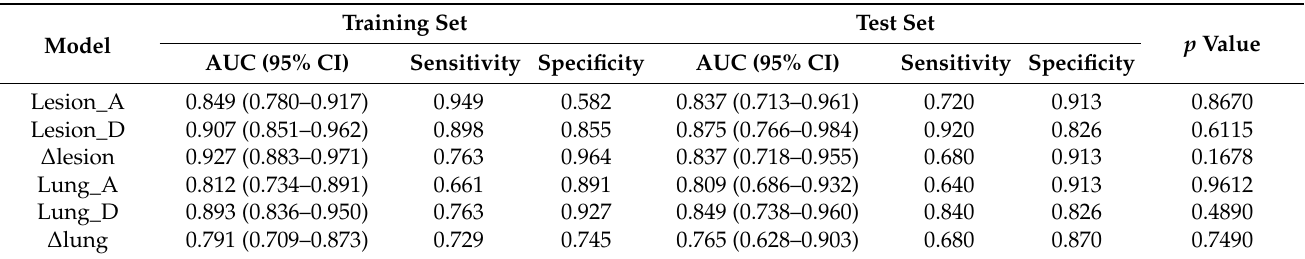
Table 3. Comparison of predictive performances of the six models in both the training and test sets. Model